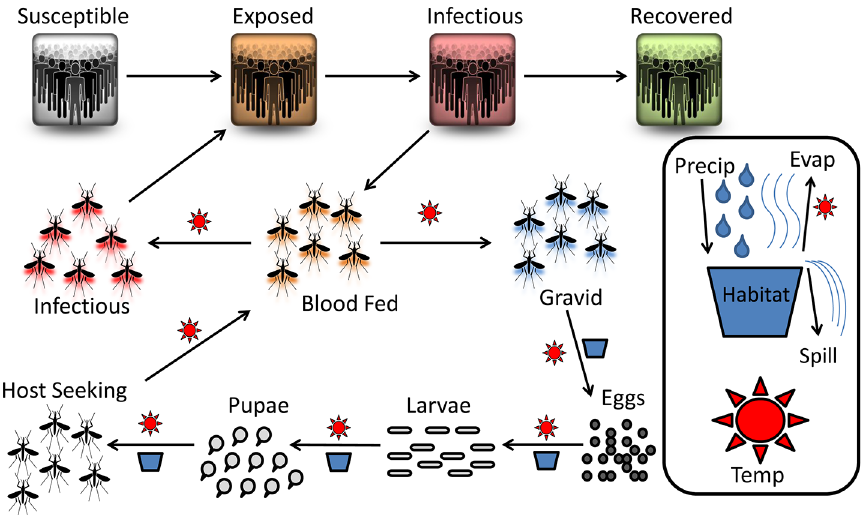
Fig 1. Conceptual diagram of modeled dengue ecology. Suns bordering an arrow indicate that the process is temperature dependent and a habitat/container symbol bordering an arrow indicates the process is habitat/precipitation dependent. Water is added to a habitat through precipitation or manual filling and is lost due to spilling and evaporation which is regulated by temperature. After hatching, the mosquitoes develop through their larval and pupal stages before emerging as adults. The adults blood feed, develop eggs, and then lay them in a water habitat. Upon blood feeding, adults can contract the virus from an infectious human. Those mosquitoes can then expose a susceptible human to the virus during a subsequent blood